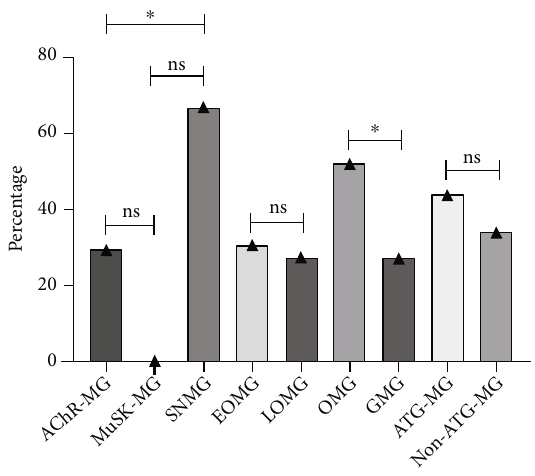
Figure 2: The proportion of each MG subtype reaching minimal manifestations status or better. Chi-square test was used for comparisons between AChR-MG and SNMG, EOMG and LOMG, OMG and GMG, and ATG-MG and non-ATG-MG. The comparisons between AChR-MG and MuSK-MG, SNMG, and MuSK-MG were performed using Fisher ’ s exact test. ∗ p < 0 : 05 ; ns: no signi fi cance.